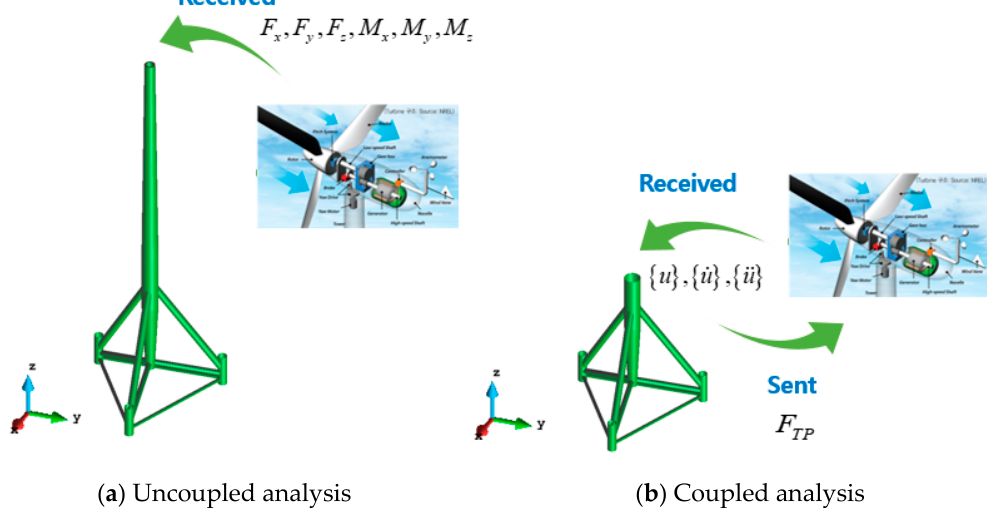
Figure 3. The concepts of uncoupled and coupled analysis.